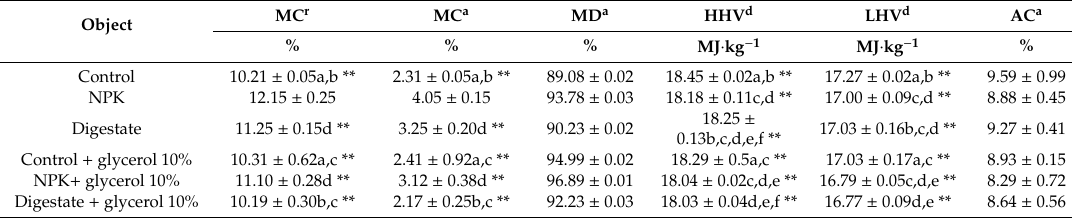
Table 3. Physical and heating properties of the